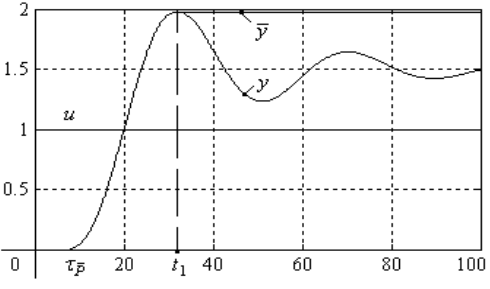
Figure 21. Process response to a unit step